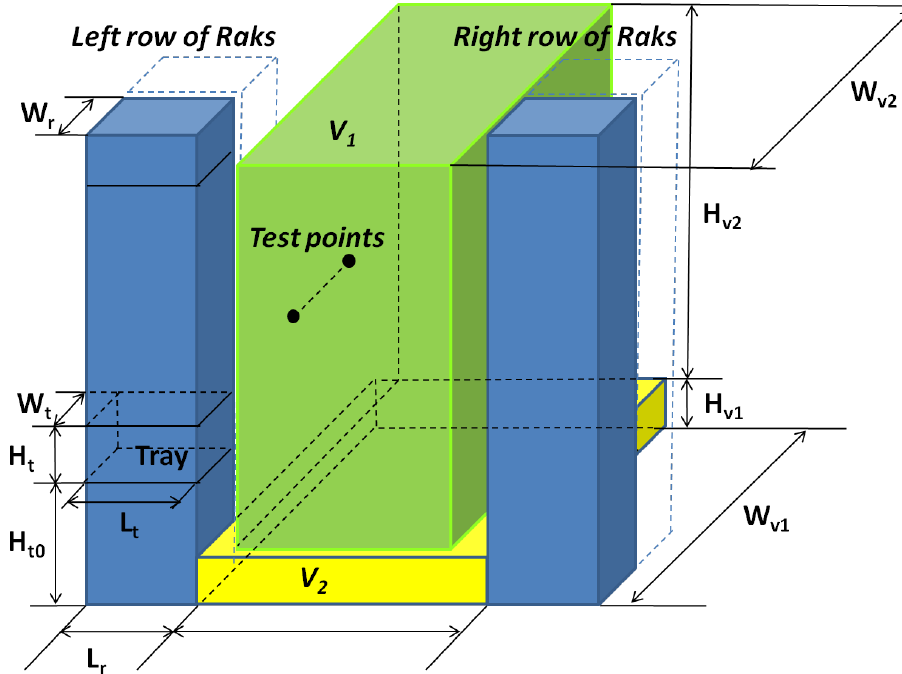
Figure 2. Position at the rack and target volumes.